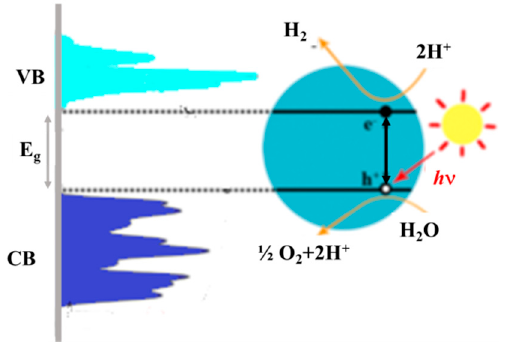
Figure 6. Scheme of the key steps of the photocatalytic reaction in a titania nanoparticle. If the incoming photon has an energy h ν greater than the value of Eg (energy gap or band gap), an electron (e − ) can be promoted from the valence band (VB) to the conduction band (CB), leaving behind a hole (h + ). The electronic structures of VB and CB were determined from X-ray Absorption and Emission Spectroscopy. Adapted with permission from [132]. Copyright 2014, American Chemical